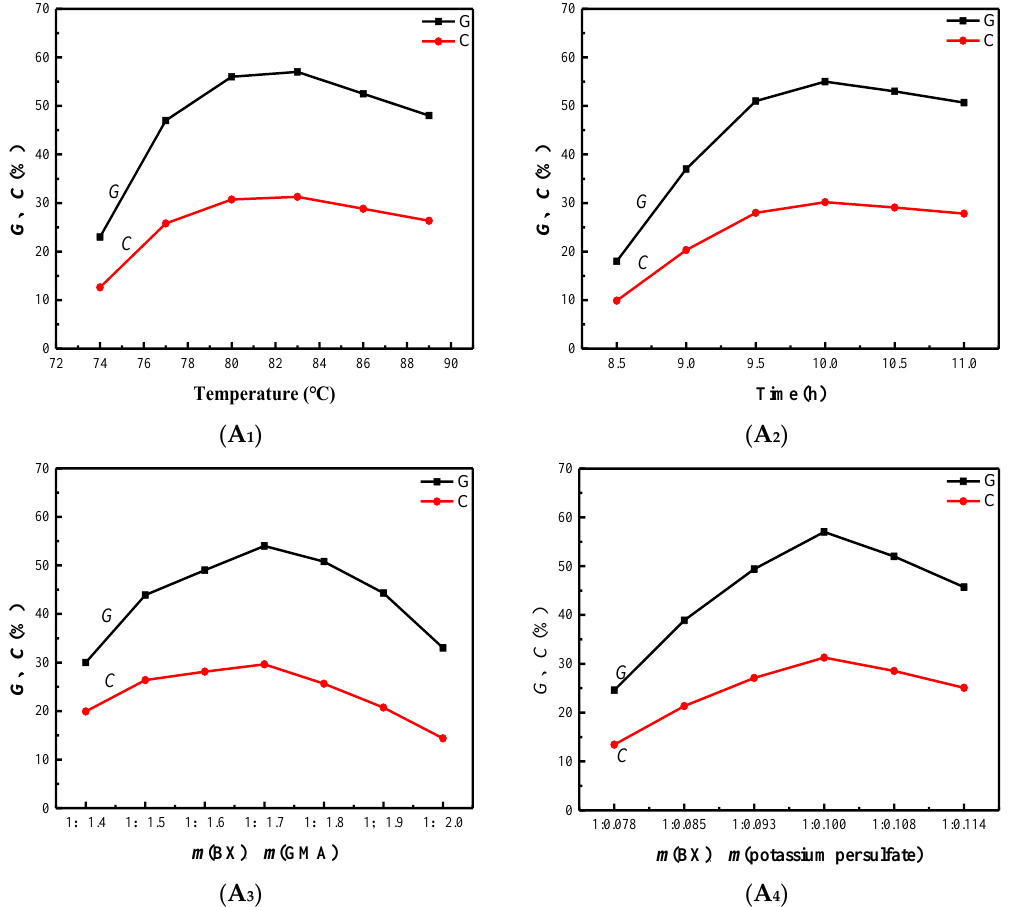
Figure 2. Effects of reaction conditions on G and C. ( A 1 ) The influence of reaction temperature on G and C. ( A 2 ) The influence of reaction time on G and C. ( A 3 ) The influence of mass of GMA on G and C. ( A 4 ): The influence of mass of potassium persulfate on G and C. The influences of A 1 , A 2 , A 3 and A 4 were discussed by keeping the other three factors constant.